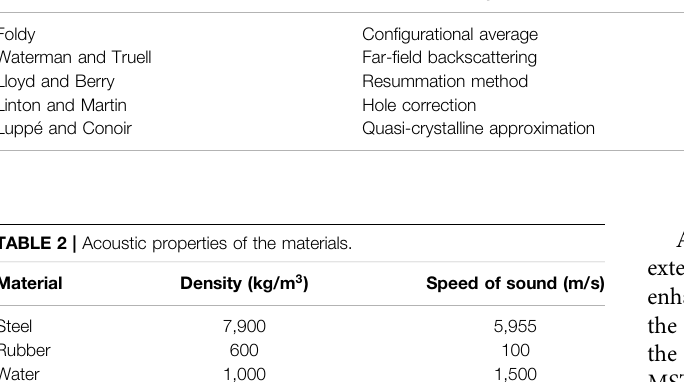
TABLE 1 | Assumption theory, abbreviations, and calculation equations of fi ve different MST models. Model